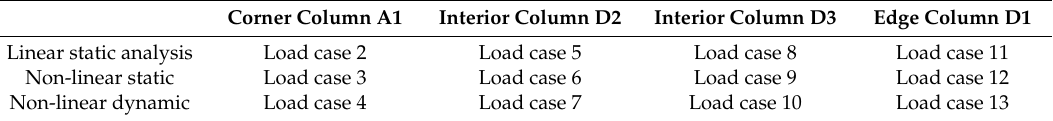
Table 5. Load cases to asses deformation-controlled actions when moment frames are used in building perimeters and shear connections are used internally.